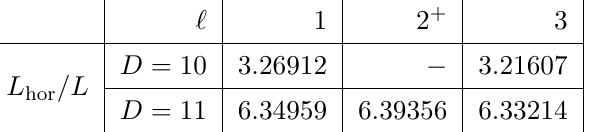
Table 2. Dimensionless horizon’s length values of the most critical solutions that we have found for the families ‘ = 1 , 3 in D = 10 and ‘ = 1 , 2 + , 3 in D = 11 . We did not construct critical enough solutions of the ‘ = 2 + family in D = 10